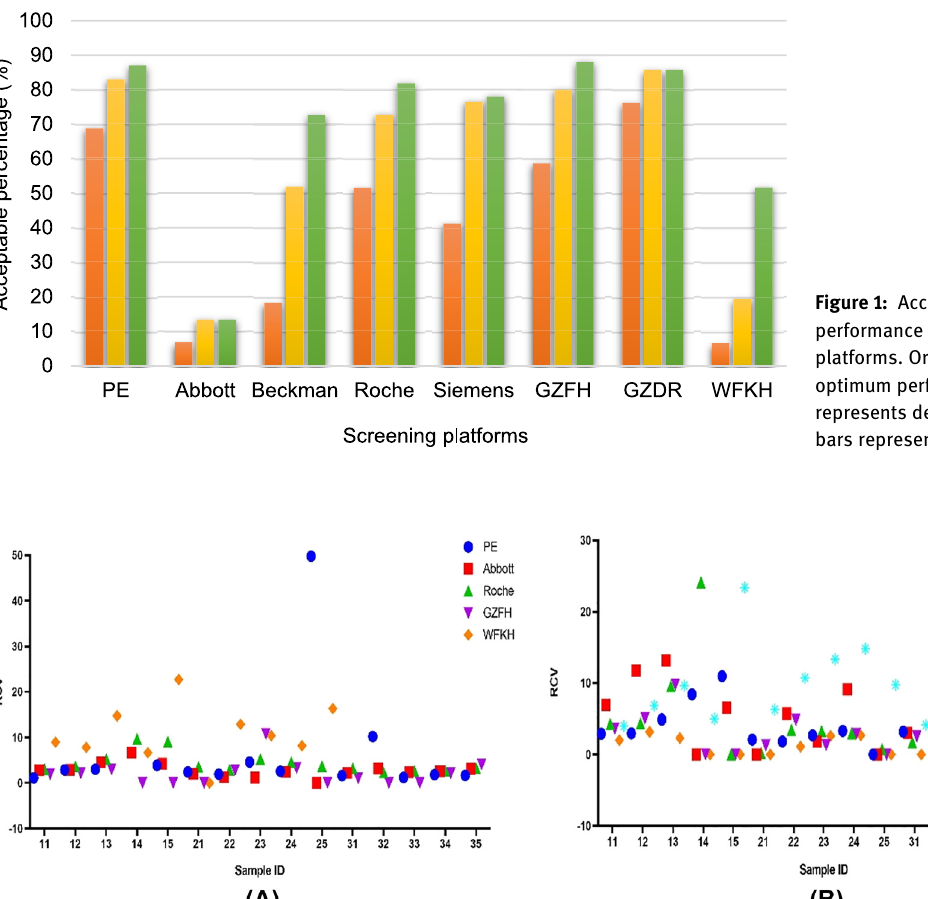
Figure 2: The RCV of each sample for different platforms in two screening protocols. (A) Double-mark screening. (B) Triple-marker